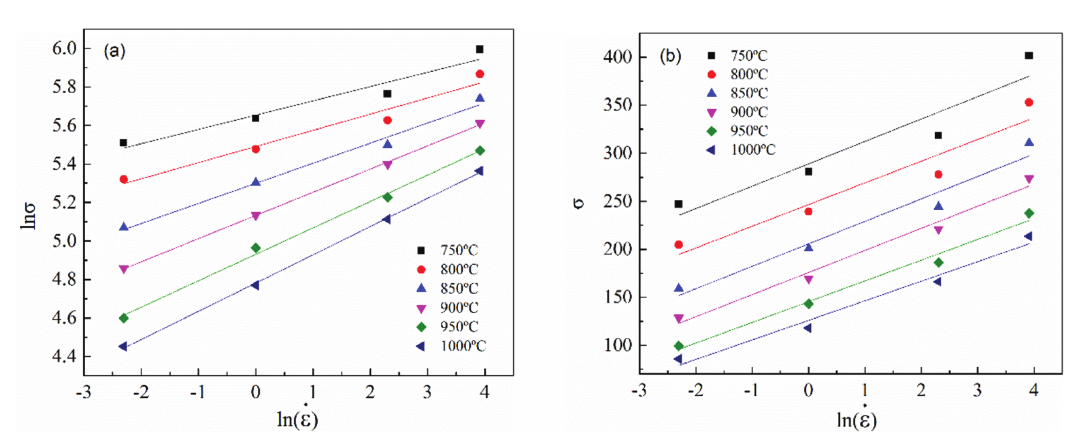
Figure 5: The value evaluation of (a) n 1 by plotting ln σ versus ln _ ε , and (b) β by plotting σ versus ln _ ε